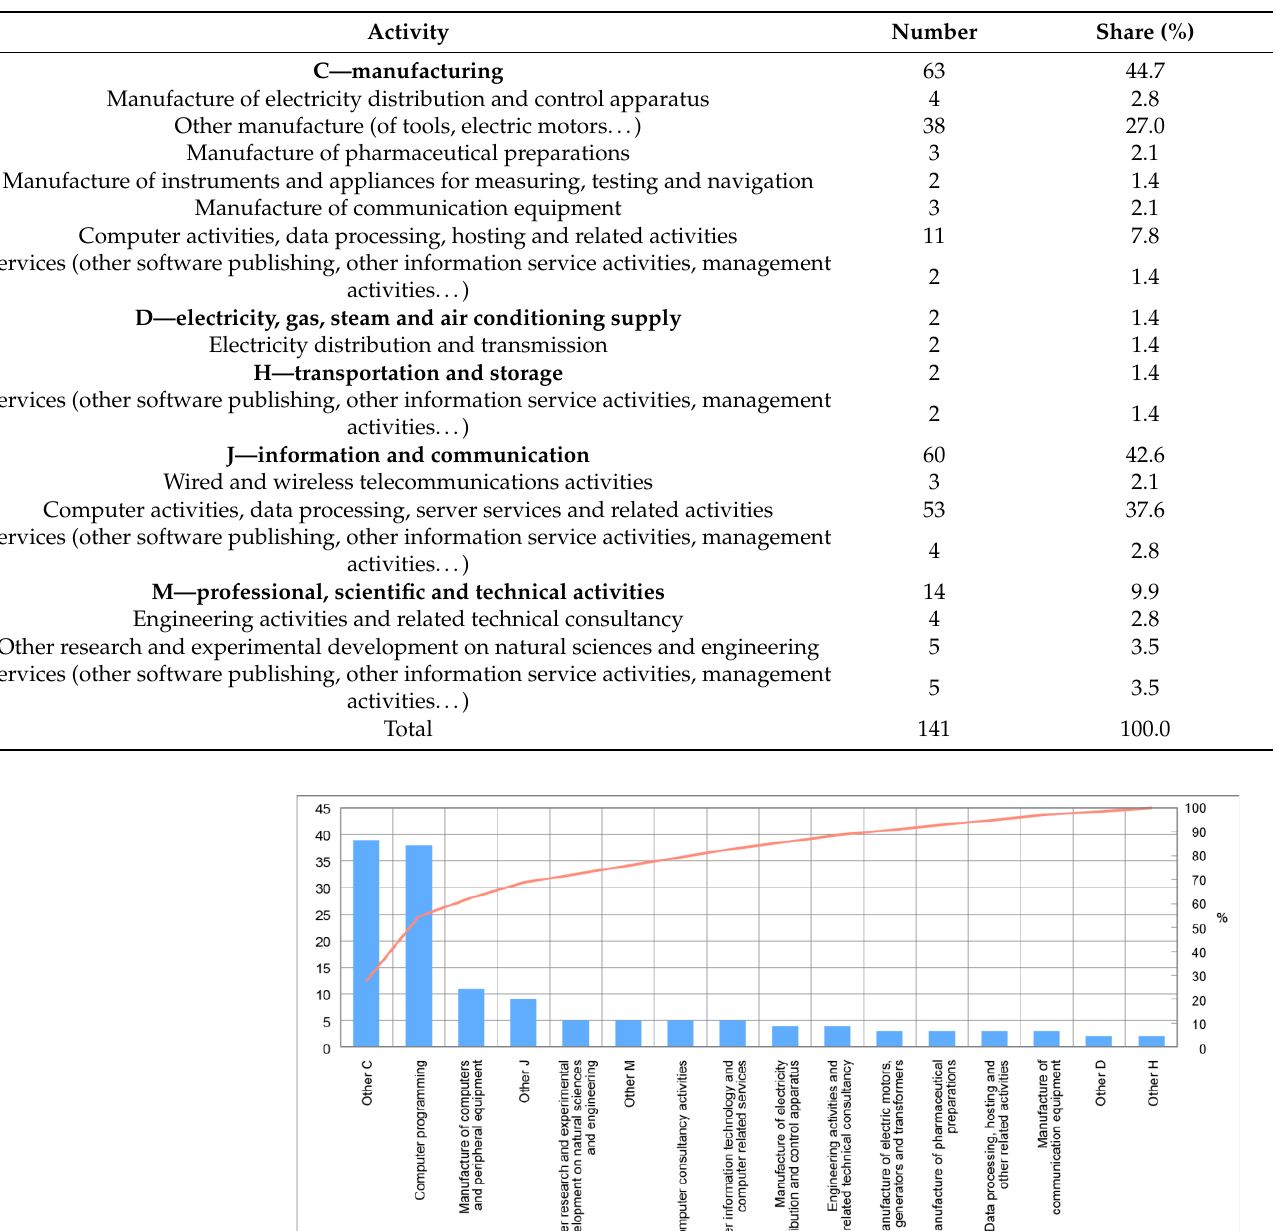
Table 3. Number and share of companies with potential for I4.0 across industries—non-probabilistic sample.